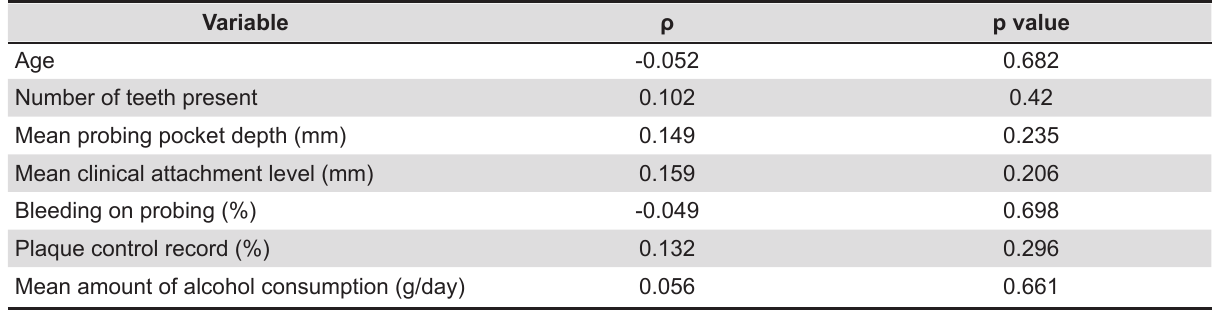
Table 3- Correlation between acetaldehyde concentration and other parameters